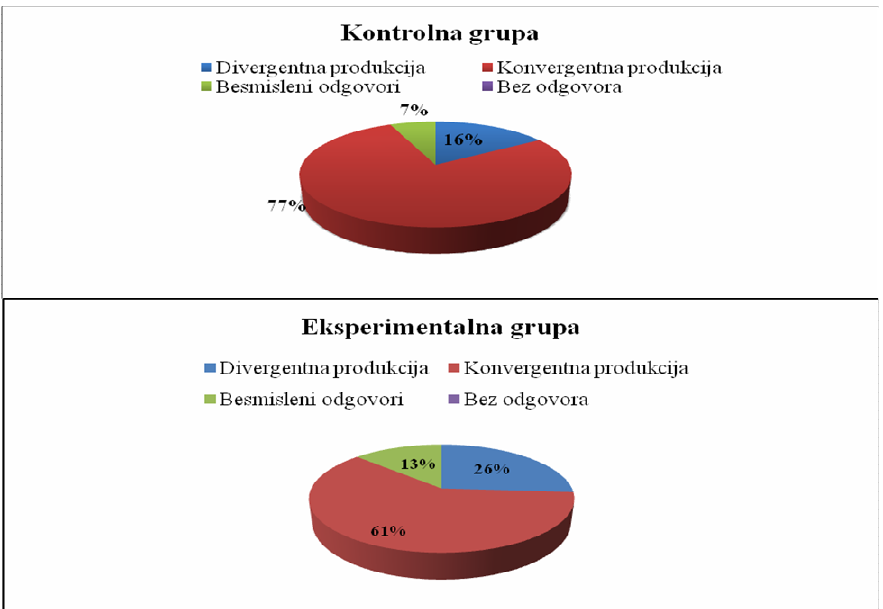
Prikaz 5. Uporedna analiza rezultata finalnog testa Statistička razlika rezultata eksperimentalne grupe inicijalnog u odnosu na finalni test je 0.187548298, što predstavlja statistički značajnu razliku jer je r>0,05. Razlika rezultata eksperimentalne u odnosu na kontrolnu grupu na finalnom testu je 0.254617389, što je statistički značajna razlika.